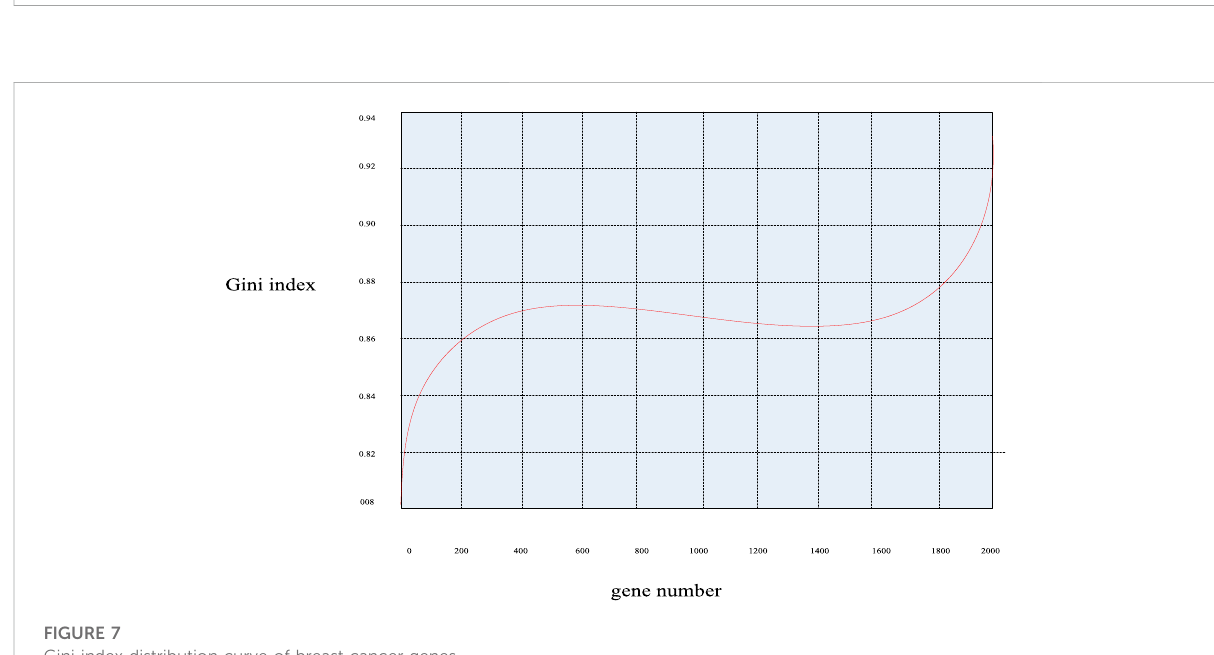
FIGURE 7 Gini index distribution curve of breast cancer